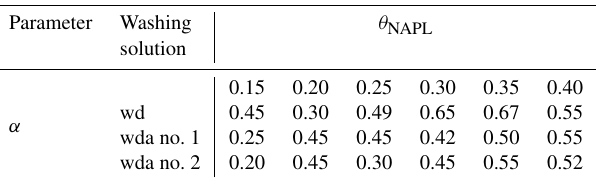
Table 1. Estimated α parameter of Eq. (10) for all three washing solutions (wd, wda no. 1 and wda no. 2) and the volumetric NAPL content ( θ NAPL )